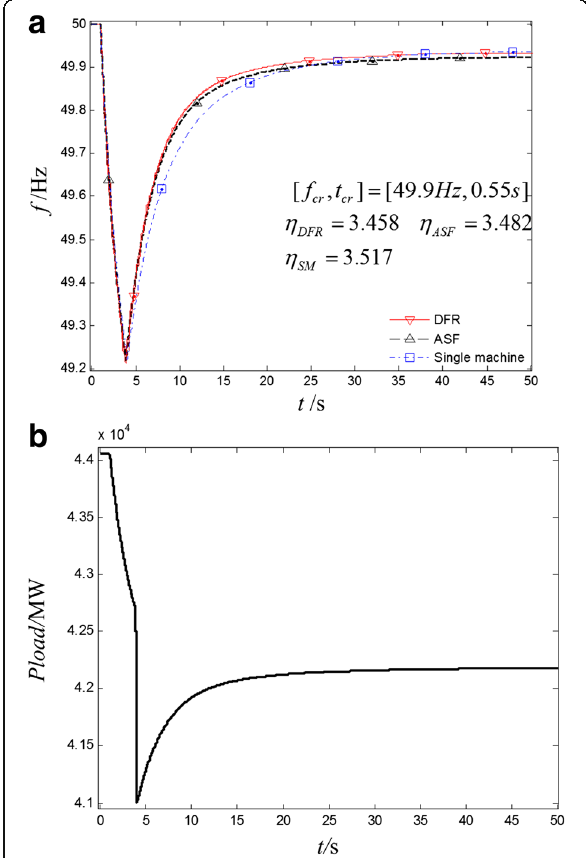
Fig. 7 Dynamics of tripping 5% generation in the 1000-bus model with UFLS control. a Frequency response. b System total load